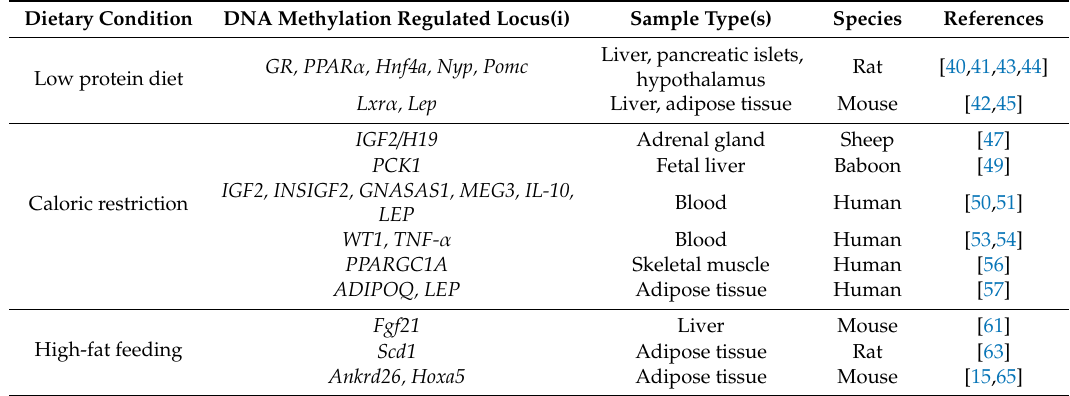
Table 1. List of relevant nutrition-sensitive DNA methylation loci in humans and model organisms. Dietary Condition DNA Methylation Regulated